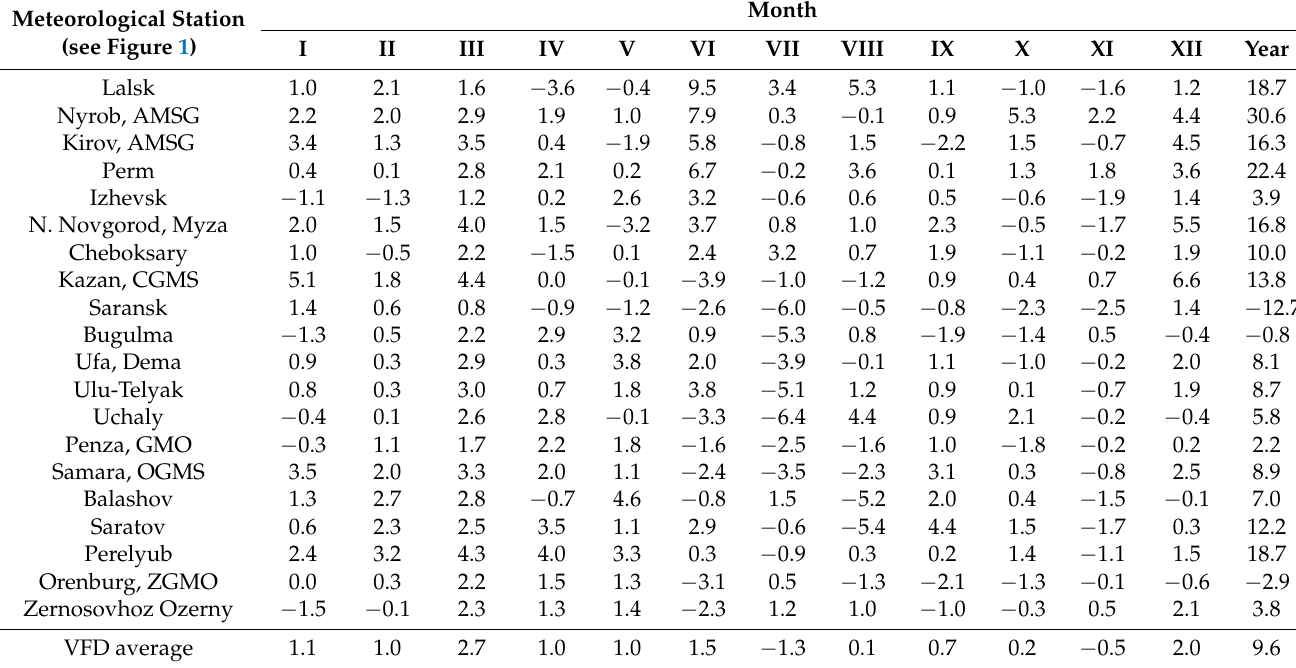
Table 4. Linear trend slope coefficients (LTSC, mm/10 years) of monthly and annual precipitation in the Volga Federal District (VFD) during